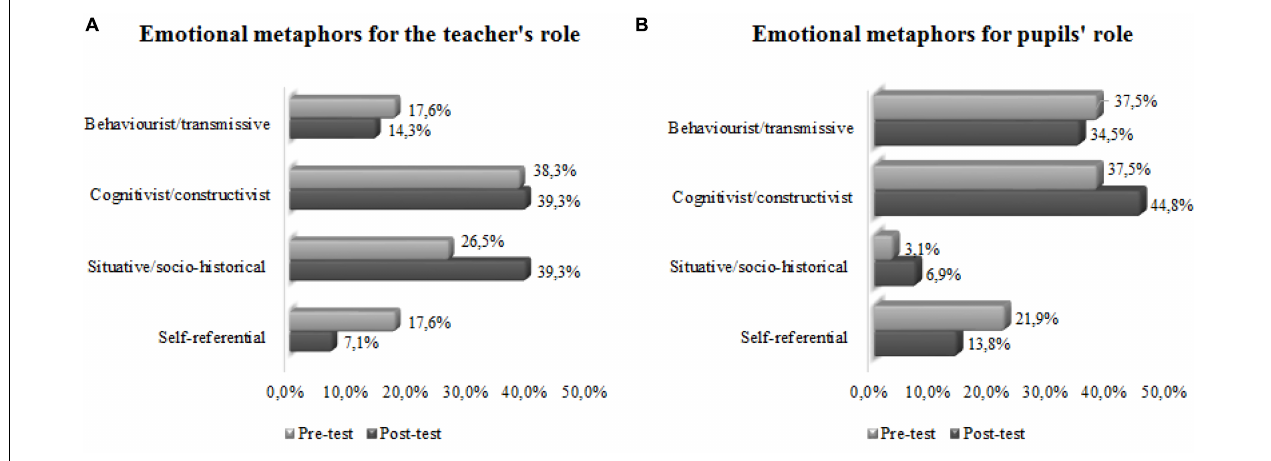
CHART 2 | (A,B) Comparison of the percentages of emotional metaphors for the teacher’s and pupil’s roles, before and after the practicum.